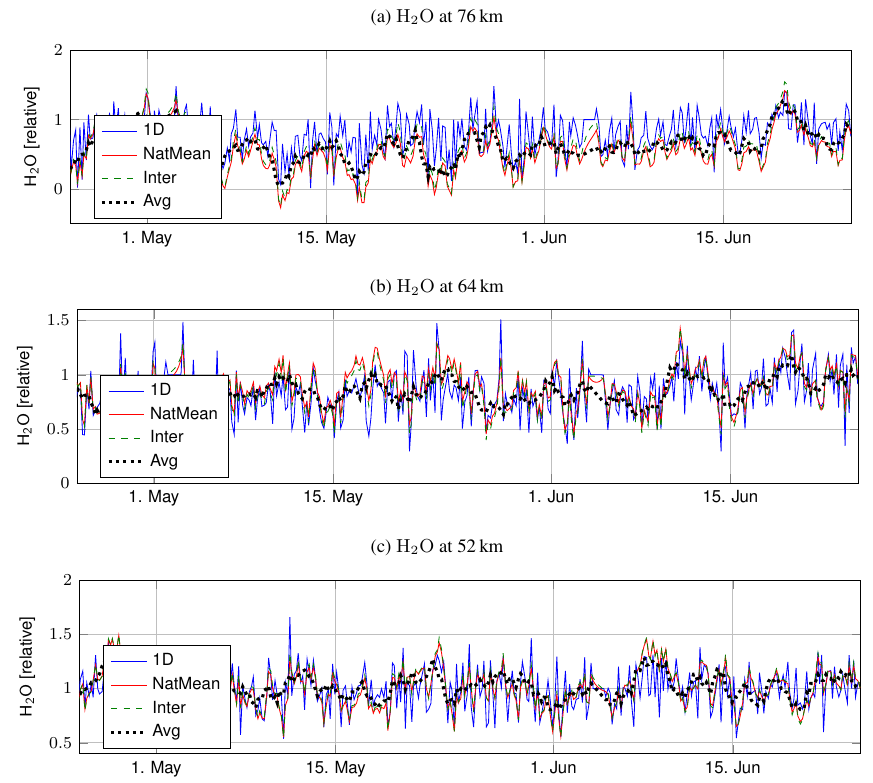
Fig. 6: H 2 O retrievals from the summer of 2005 obtained by the OSO radiometer. The results are relative to the a priori concentration and are shown for 76km (a), 64km (b) and 52km (c). The different curves represent the single spectrum inversions (blue), the time series inversions using the NatMean (red) and the intermediate covariance matrix (dashed-green), and the inversions using the averaged spectra (black-dashed).